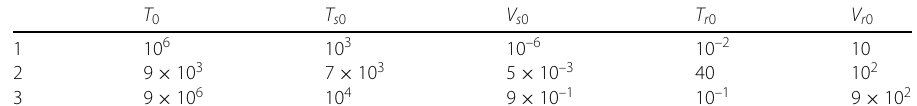
Table 4 Initial values of model (2)